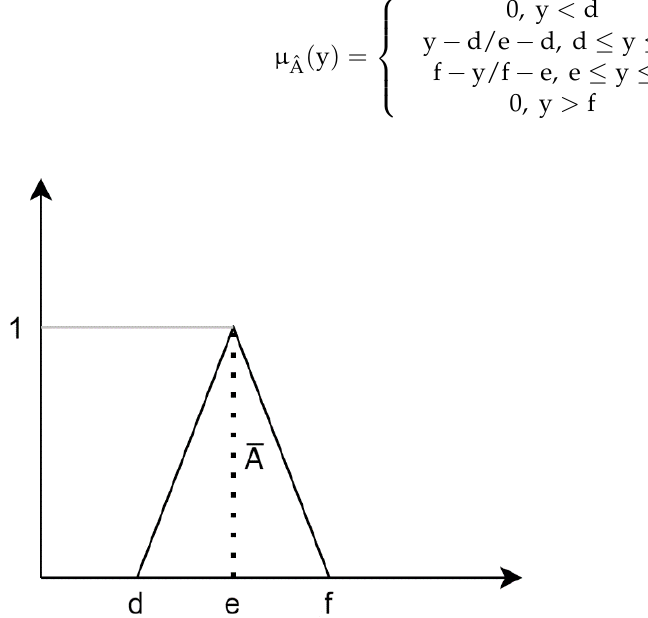
Figure 2. The presentation of fuzzy triangular membership functions. Fuzzy numbers are not fit for matrix calculations. Therefore, a defuzzification algo- rithm can be used for fuzzy aggregation. The Converting Fuzzy data into Crisp Scores (CFCS) method can be utilized to obtain a crisp value of the total-relation matrix [51]. The left and right-side calculations are carried out by fuzzy minimum and maximum based on the fuzzy number range. Finally, the total crisp value is computed as per the membership function. The steps of the CFCS method are as follows: 1. Normalization of the fuzzy numbers is carried out with the following Equations (8)–(11).